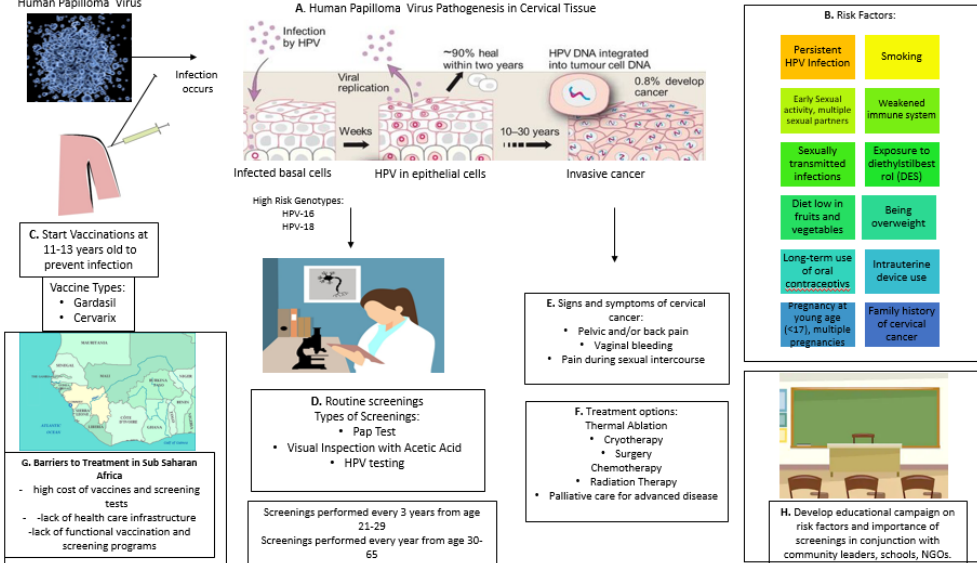
Figure 1. Cervical cancer pathogenesis, role of human papilloma virus (HPV), impact of vaccination, symptoms and potential treatments, and risk factors for cervical cancer development. ( A ). Human Papilloma Virus (HPV) Pathogenesis, ( B ). Risk factors, ( C ). HPV vaccinations, ( D ). Routine screening and types of tests, ( E ). Signs and symptoms of cervical cancer, ( F ). Treatment options, ( G ). Barriers to containment of cervical cancer, ( H ). Developing educational